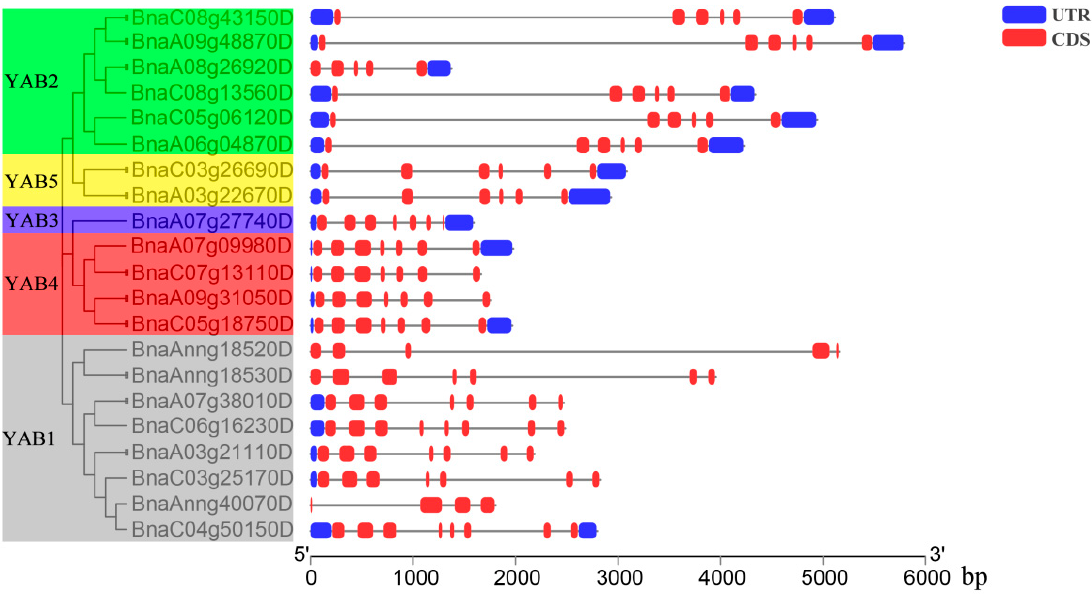
Figure 3 . Exon–intron structures of the 21 BnaYAB genes, ordered based on their phylogenetic positions.